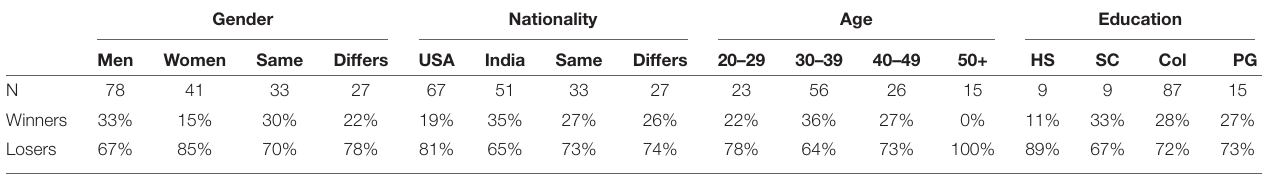
TABLE 7 | Demographics overall and of winners vs. losers (excluding prefer not to say for gender and nationality) and also for teams that include the same or different genders and nationalities. Gender